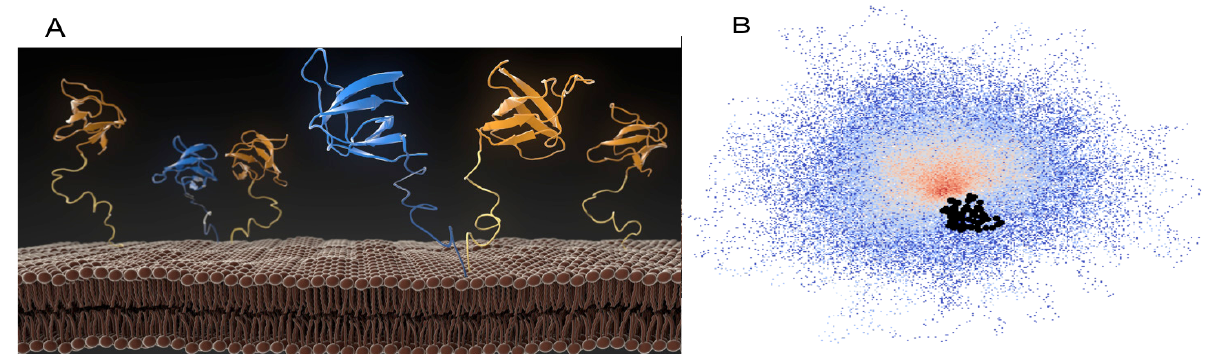
Figure 5: c-Src N-terminal region. A. Artist view of the dimerization of c-Src by its myristoylated SH4 domain when anchored to lipid membranes (adapted from Chem. Select cover figure to reference 56 under CC-BY-NC license). B. Relative volumes of the SH3 domain (black) and the space visited by adjacent disordered domains, represented by the cloud formed by the position of the C a carbons in an ensemble compatible with SAXS experimental